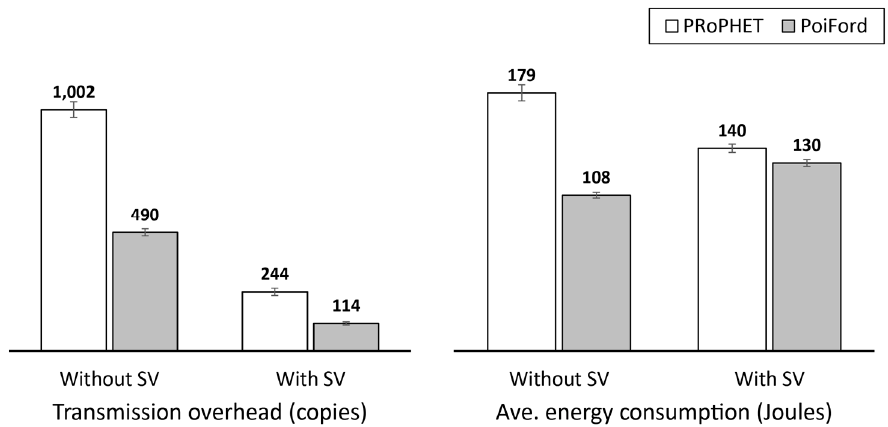
Figure 11. Message transmission overhead and average energy consumption of PRoPHET and